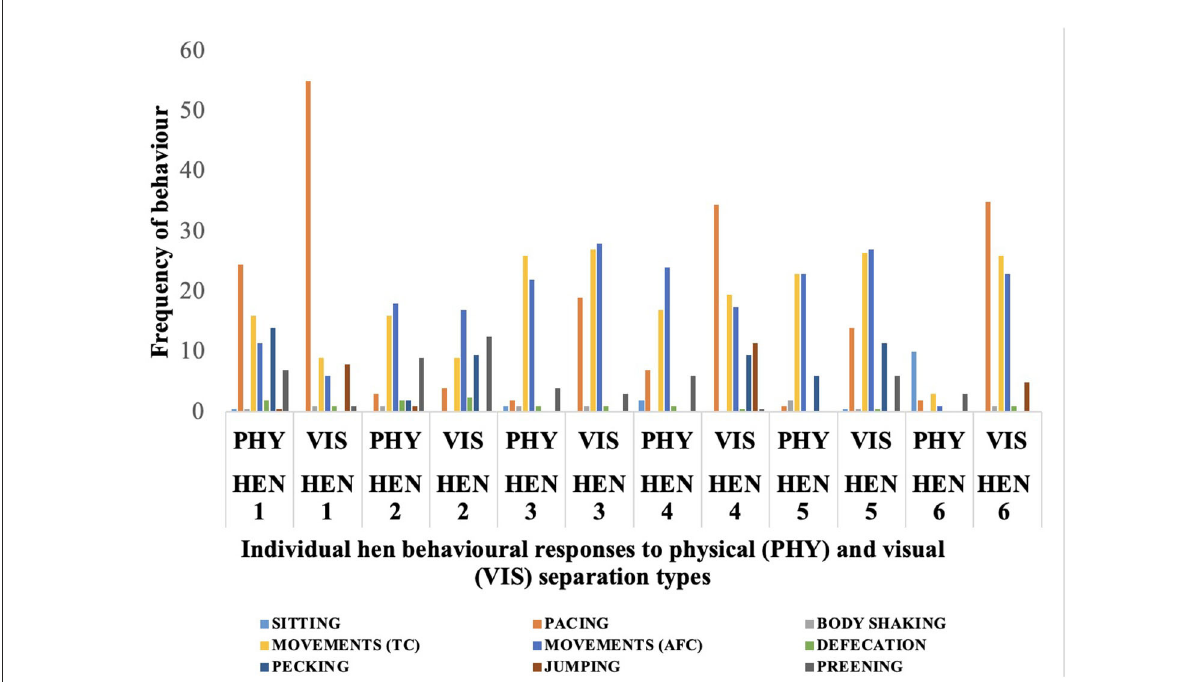
FIGURE2 Frequency of behaviors exhibited by each of the six hens during the physical (PHY) and visual (VIS) separation tests for 10-minutes from their chicks. 1-6 represent the individual hen numbers. TC, toward chicks; AFC, away from chicks.